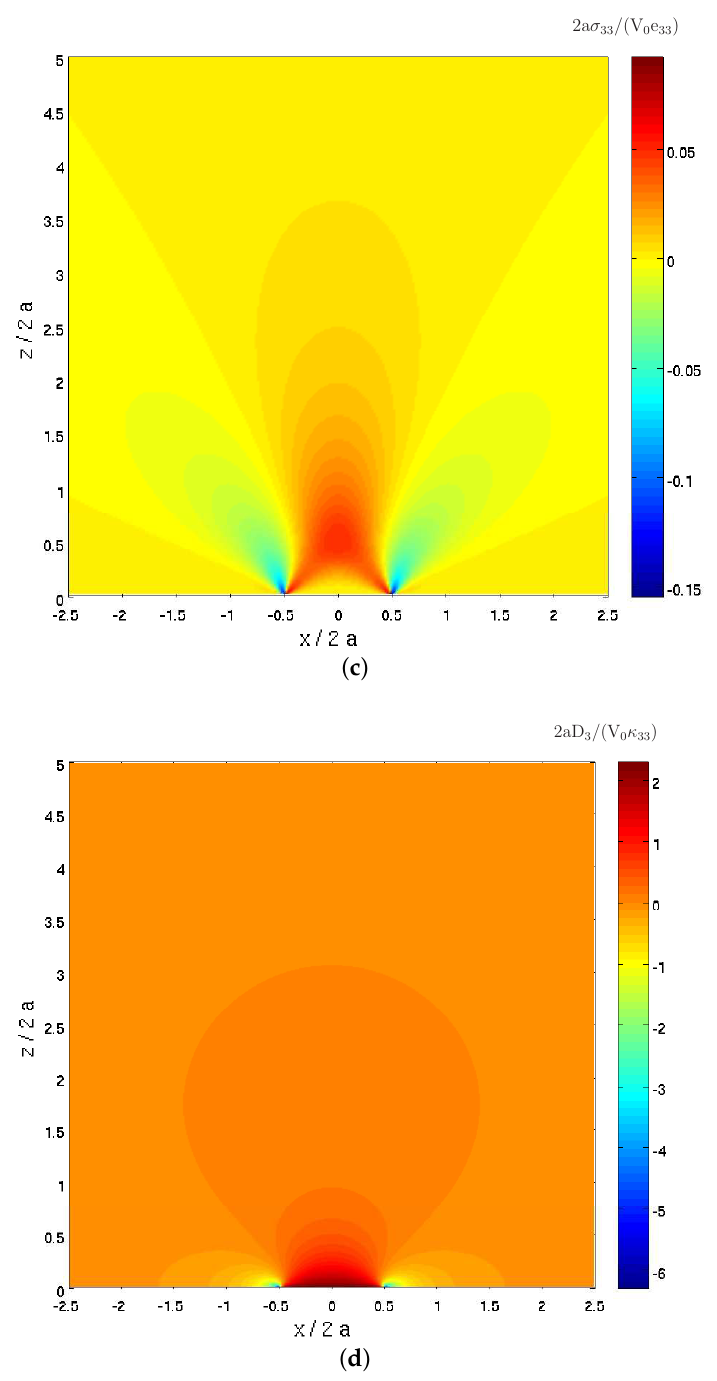
Figure 2. A homogeneous piezoelectric (PZT-7A) half-plane attached to an electrode of electric potential V 0 at z = 0. ( a ) Comparisons of the variations of the induced stresses σ 11 , σ 33 , and σ 13 ; the electric displacement D 3 ; and the electric field E 3 along x 1 at z / a = 1, as obtained by the present analysis and the exact solution. ( b ) The predicted distribution of the induced normal stress σ 33 in the region − 2.5 ≤ x /2 a ≤ 2.5, z /2 a ≤ 5. ( c ) The exact distribution of the induced normal stress σ 33 in the region − 2.5 ≤ x /2 a ≤ 2.5, z /2 a ≤ 5. ( d ) The predicted distribution of the induced normal electric displacement D 3 in the region − 2.5 ≤ x /2 a ≤ 2.5, z /2 a ≤